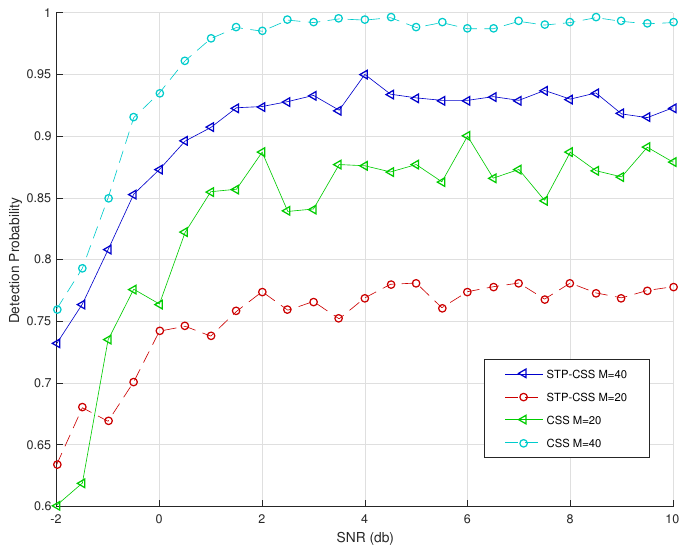
Figure 8. Comparison of the reconstructed signal in CSS and STP-CSS, where the numbers of the measurement matrix were set to 20 and 40.